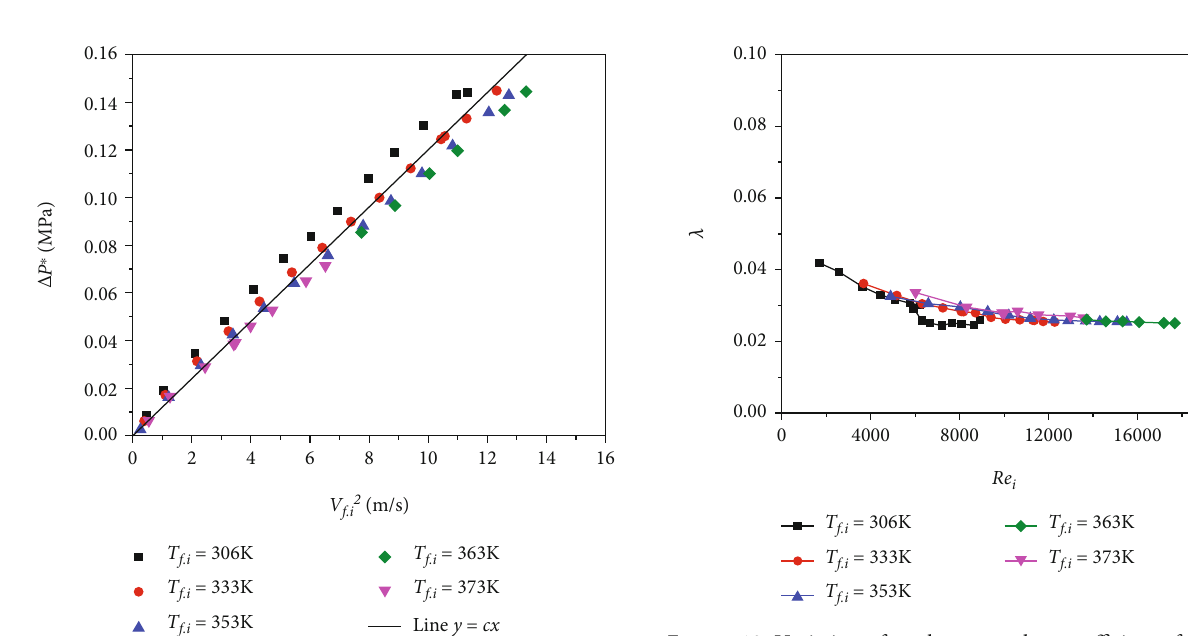
Figure 17: Total pressure loss variation with inlet velocity square in pilot fuel circuit.